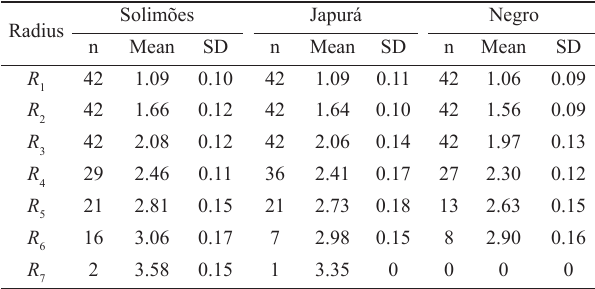
revealed a high variability among individuals, showing four